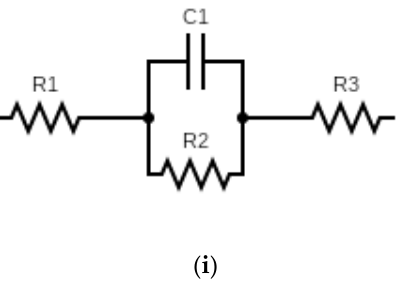
Figure 8. Comparative CCD plots for ( a ) specific capacitance vs. cycle number, ( b ) retention (%) vs. cycle number, ( c ) specific capacitance vs. current density. ( d ) Ragone plot, ( e ) EIS plot for Lig-MnO 2 supercapacitor, and ( f ) EIS plot for AC/Lig-MnO 2 supercapacitor. ( g ) EIS fitted curve at 500 cycles for Lig-MnO 2 supercapacitor, ( h ) EIS fitted curve at 500 cycles for AC/Lig-MnO 2 supercapacitor, ( i ) equivalent circuit for EIS